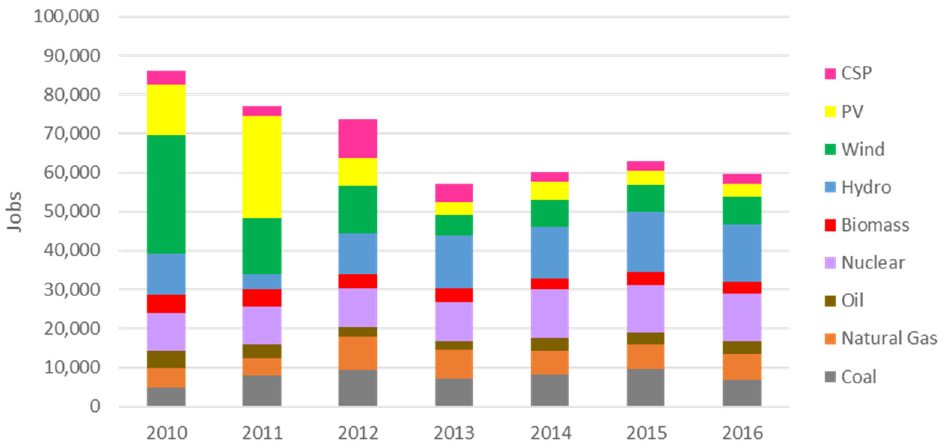
Figure 13. Historic data (2010–2016) describing employment generation of Spain’s electricity system per